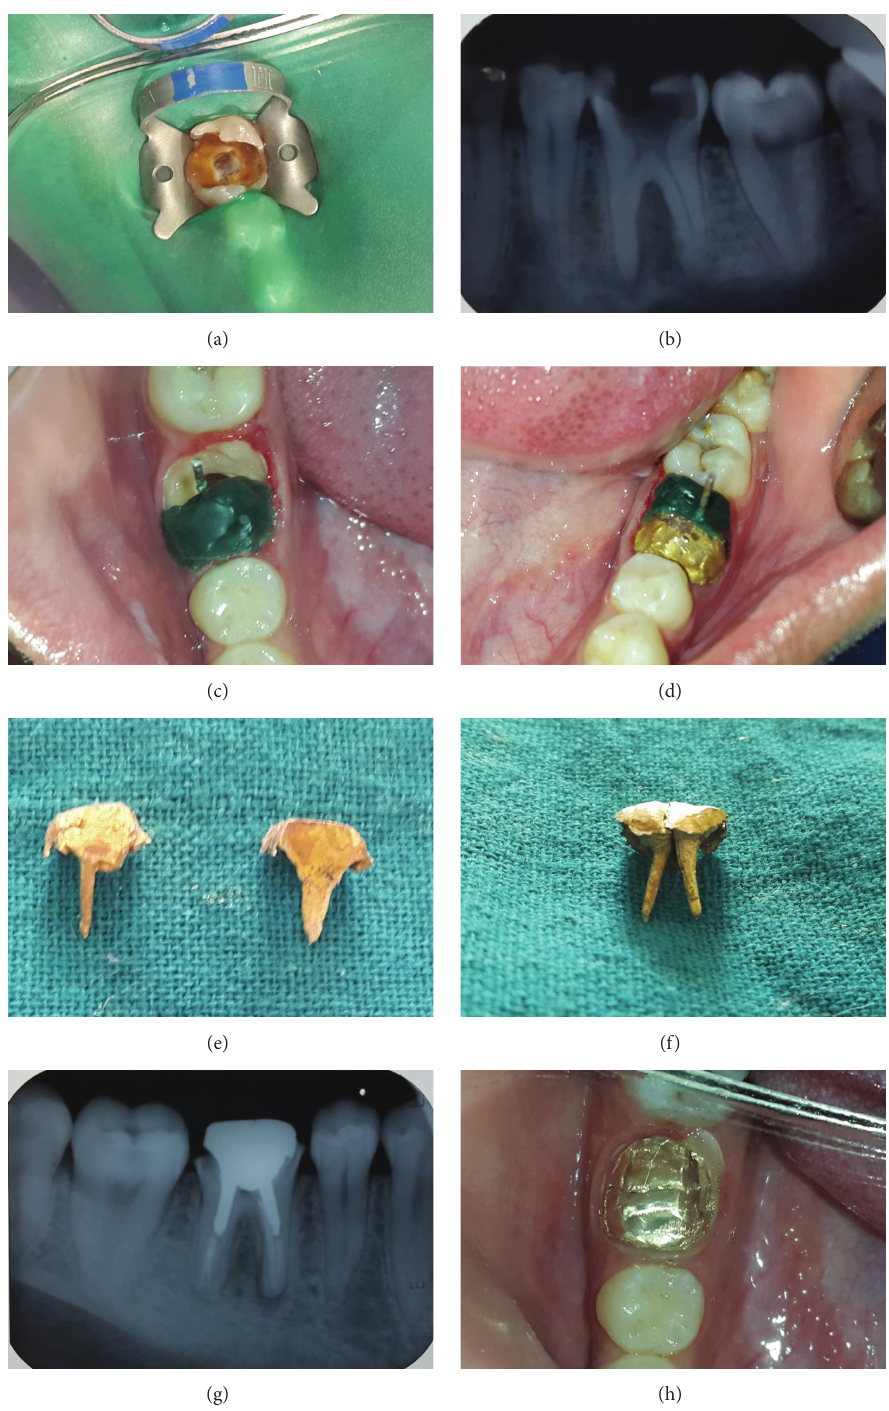
Figure 1: (a) Preoperative intraoral photograph showing grossly carious tooth. (b) Preoperative IOPAR showing grossly decayed molar with roots showing parallel configuration. (c) Fabrication of wax pattern in mesiolingual canal involving mesial half of the tooth. (d) Wax pattern fabrication of the distal half with mesial post and core in place. (e) Mesial and distal sections of split cast post and core. (f) Assembly of mesial and distal sections of split cast post and core. (g) IOPAR of luted and finished split cast post and core. (h) Luted and finished split cast post and